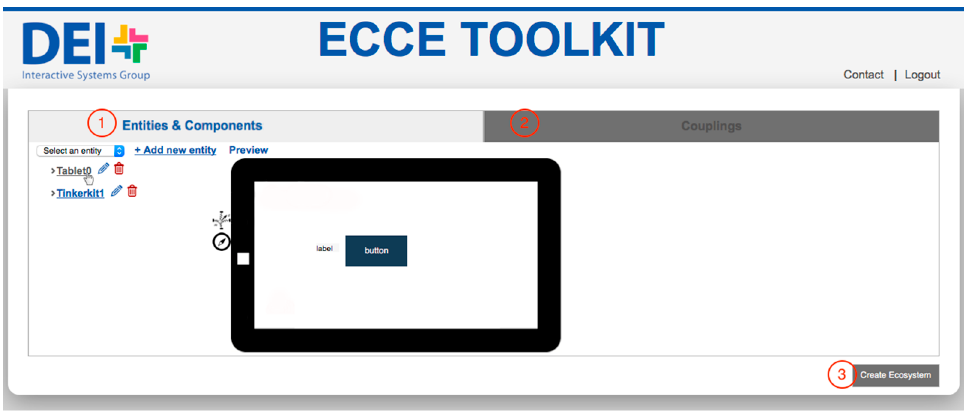
Figure 1. Web interface of the ECCE Authoring Environment to create an ecosystem: (1) add/edit new entities via the Entity & Components Editor and (2) define their behavior (Couplings Editor). By selecting an existing entity, a preview gives users a prompt feedback regarding the entity design. (3) Users can automatically generate the runtime code of the entities as well as the server logic (Ecosystem Code Generator).